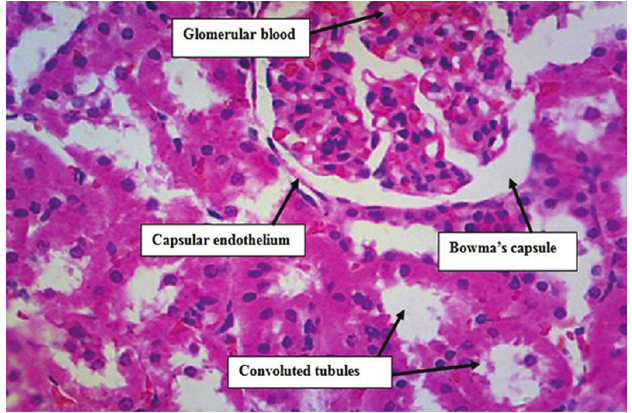
FIGURE 10 - Effect of risperidone on the kidneys of rats (2.5 mg/kg/d) (H & E, 400x,5 µ): Representative image of kidney of rats treated with risperidone orally for three weeks showing thin walled endothelium of Bowman’s capsule, glomeruli with intact cellular borders, blood perfusion and convoluted tubules.